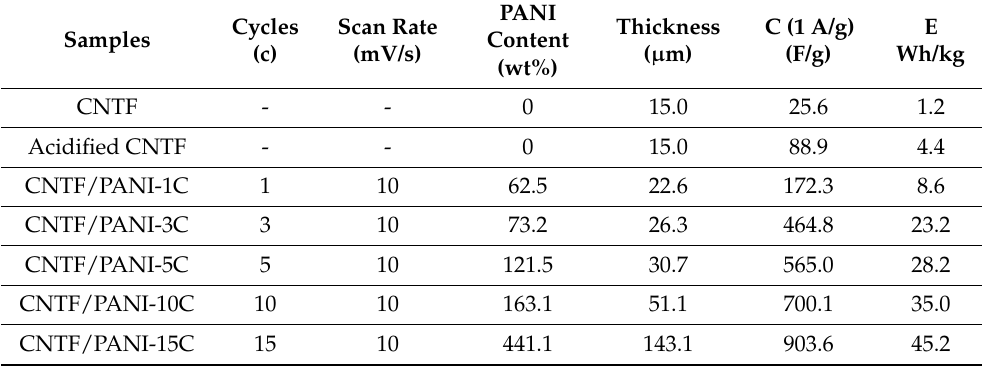
Figure 1. ( A ) Cyclic voltammogram of electrochemical synthesis of the CNTF/PANI-5C sample; ( B ) CNTF/PANI-10C sample; and ( C ) CNTF/PANI-15C sample. Table 1. The influence of different electrochemical polymerization